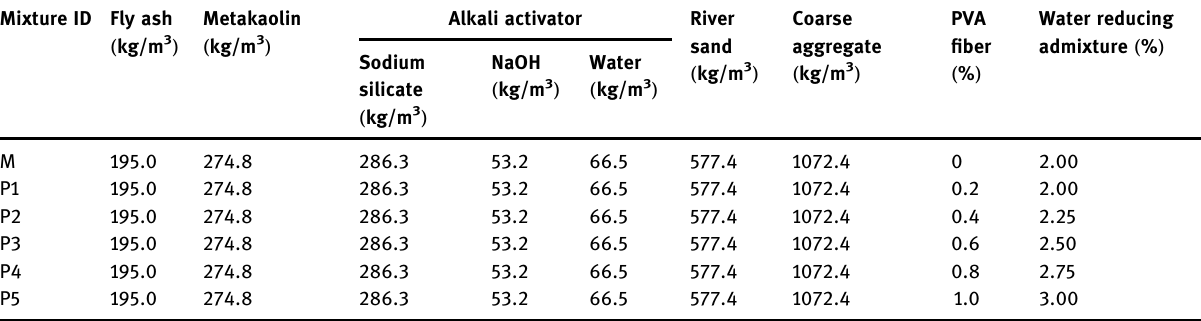
Table 4: Mix proportions of fi ber - reinforced GPC Mixture ID Fly ash Metakaolin ( kg/m 3 ) ( kg/m 3 )